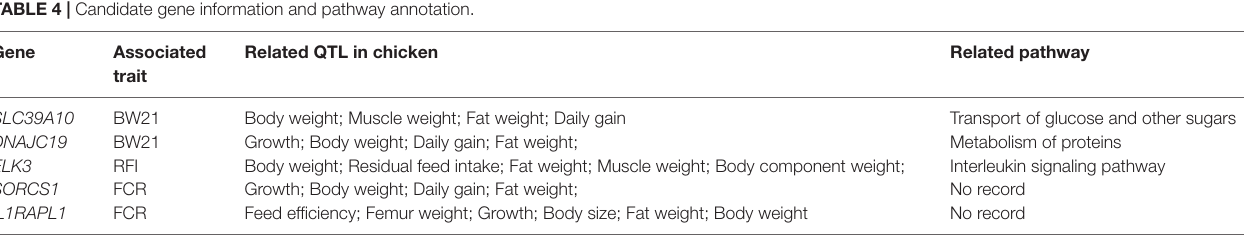
TABLE 4 | Candidate gene information and pathway